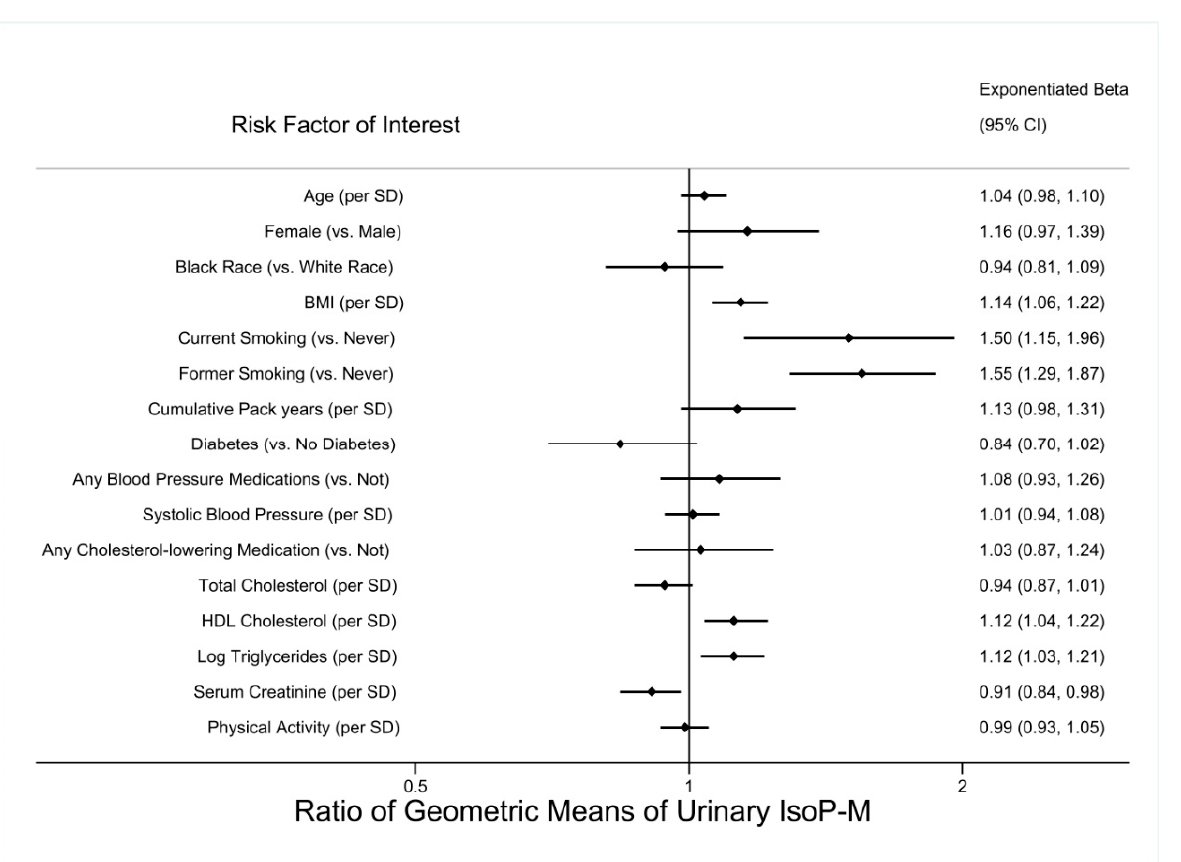
Figure 3. Adjusted associations between IsoP m vs. cardiovascular risk factors. Exponentiated beta-coefficients are plotted and are equivalent to geometric ratios of analyte of interest. Ratios > 1 represent positive correlation and ratios < 1 represent inverse correlation. All CVD risk factors are mutually adjusted for one another (age, sex, race, BMI, smoking status, cumulative pack years, diabetes, hypertension medication, systolic blood pressure, lipid-lowering medication, total cholesterol, HDL cholesterol, fasting triglyceride concentrations [log transformed], physical activity) as well as for college attainment and study center. Smoking status and cumulative pack years were highly correlated and thus were not adjusted for one another in their respective models.